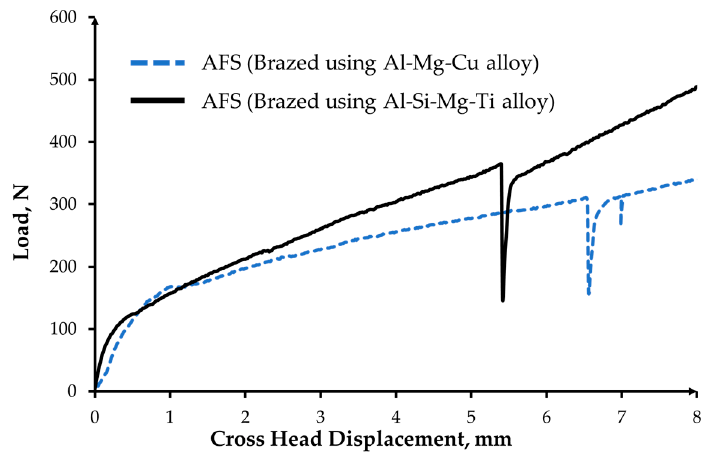
Figure 10. Flexural behaviour of AFS components produced using Al-based amorphous brazing alloy.